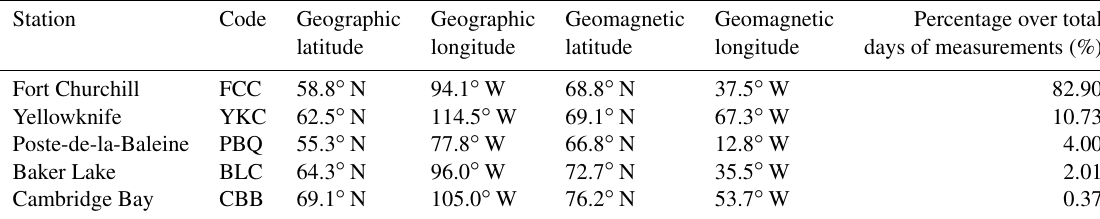
Table 2. Coordinates of CANMOS observatories used in this work. Station